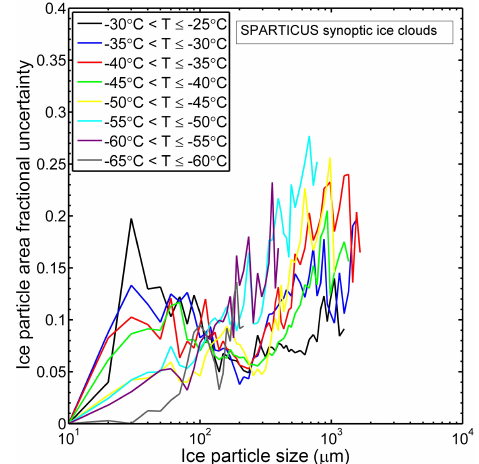
Figure 6. Fractional uncertainties (standard deviation/mean) for the mean ice particle projected area in each bin of the measured PSDs. Only temperature intervals having more than two PSDs are consid- ered.